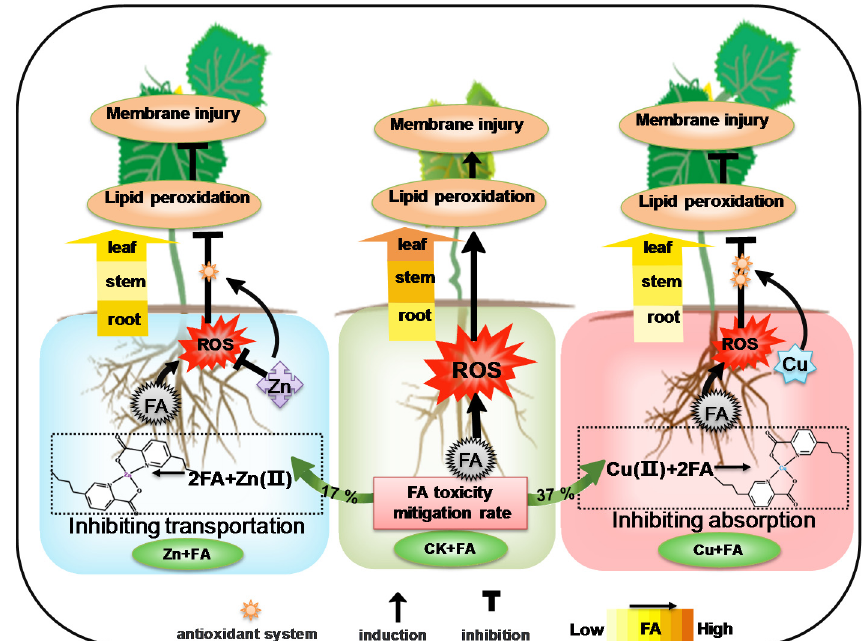
Figure 6. Ions enhance the tolerance of cucumber to fusaric acid by different mechanisms. Changing transportation (Zn) or absorption (Cu) and chelation reaction plays pivotal roles in toxicity mitigation of FA. Zn or Cu alleviates the ROS damage (lipid peroxidation, membrane injury) of FA to cucumber plants by modification in antioxidant enzymes system. The mitigation reaction, which could involve chelation, occurs in both Zn + FA and Cu + FA treatments. The arrow in green indicates the mitigation rate compared to the control. Arrows in yellow represent the transportation of FA to the ground under different treatments. Different degrees of yellow represent the FA content.